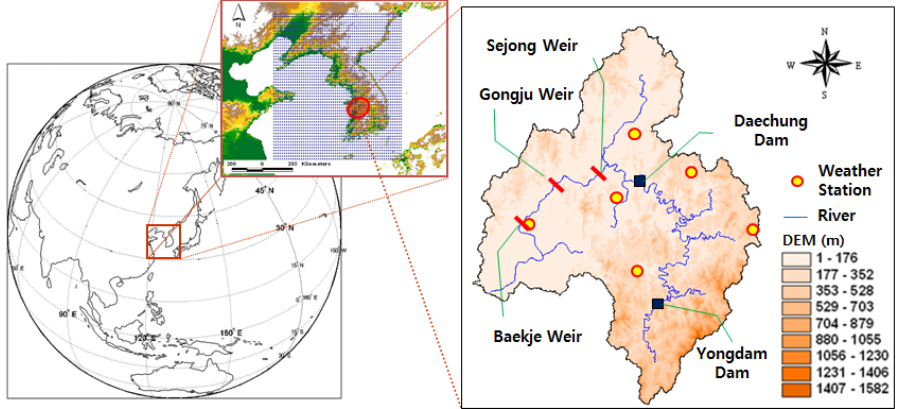
Figure 3. Study area (Geum River basin).